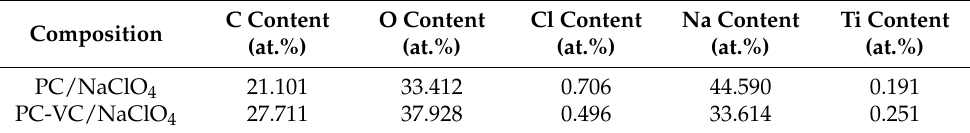
Table 1. Quantification of elements present in the TiO 2 nanosheet electrode surface film after 30 cycles in VC-containing and VC-free electrolyte solutions (based on XPS measurements). Composition (at.%)